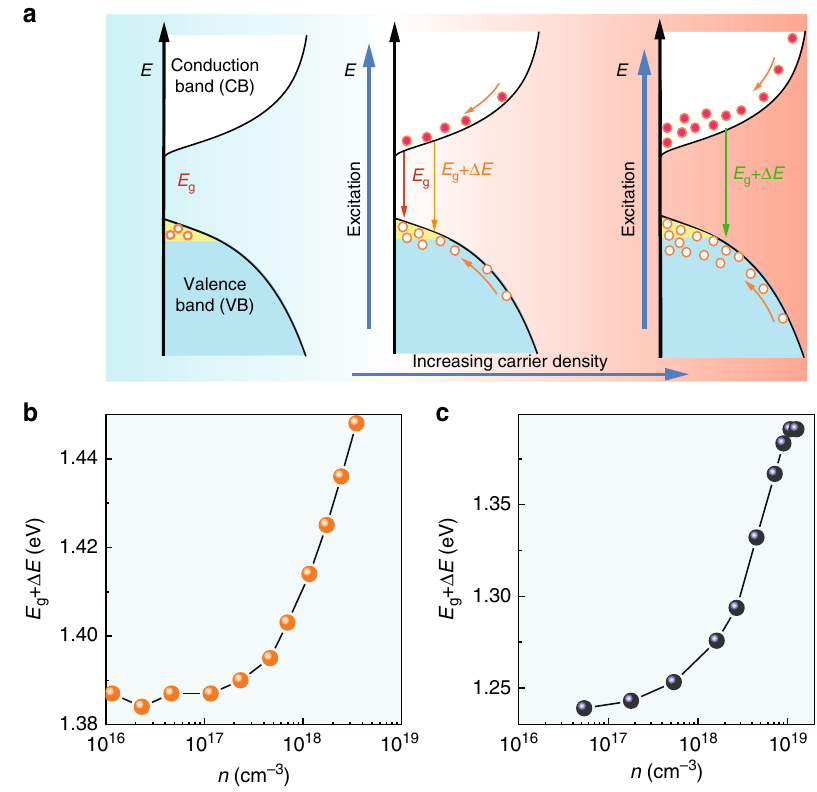
Fig. 2 Blue shift of the photoluminescence. a Schematic of the mechanism for the blue shift of the PL as a result of band fi lling. b and c emission peak energy versus the photocarrier density n at 293 and 24 K, Fig. 4b for emission energies of 1.65, 1.41, and 1.38 eV. The hot- carrier PL at the high-energy tail of the spectra (1.65 eV) shows an initial rapid cooling with a time constant of t = 0.16 ns, followed by a signi fi cantly slower relaxation process taking up to 4.5 ns. In order to obtain the carrier temperature as a function of time, the PL spectra at different delay times are extracted. The spectra have a high-energy tail that decays exponentially with energy, whose line shape is approximated to be a modi fi ed